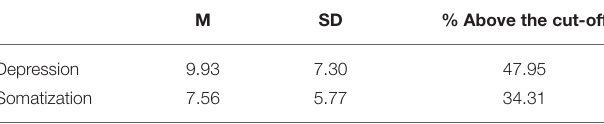
TABLE 2 | Means and standard deviations for psychopathology symptom measures. M SD % Above the cut-off Depression